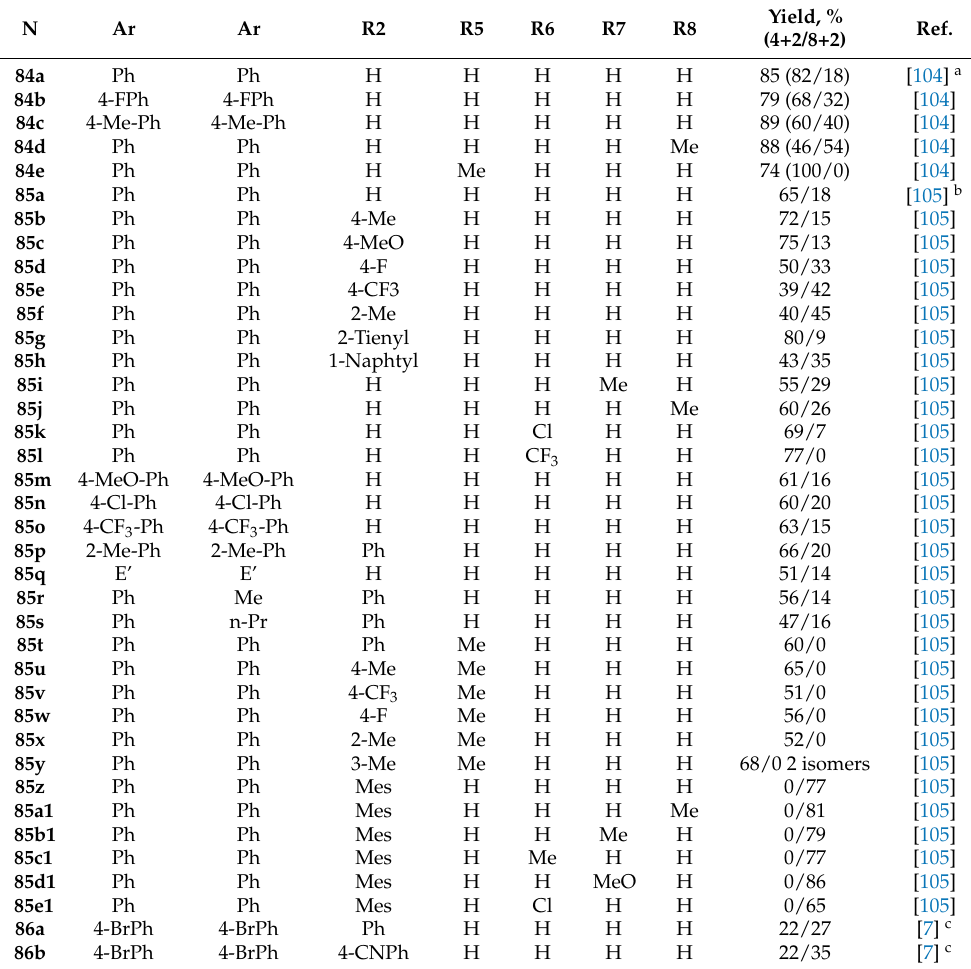
Table 22. Substituents, yields and ratio of isomers in concurrent 2+4 and 2+8 cycloadditions of 2-arylazaindolizines and acetylenes (Scheme 48).